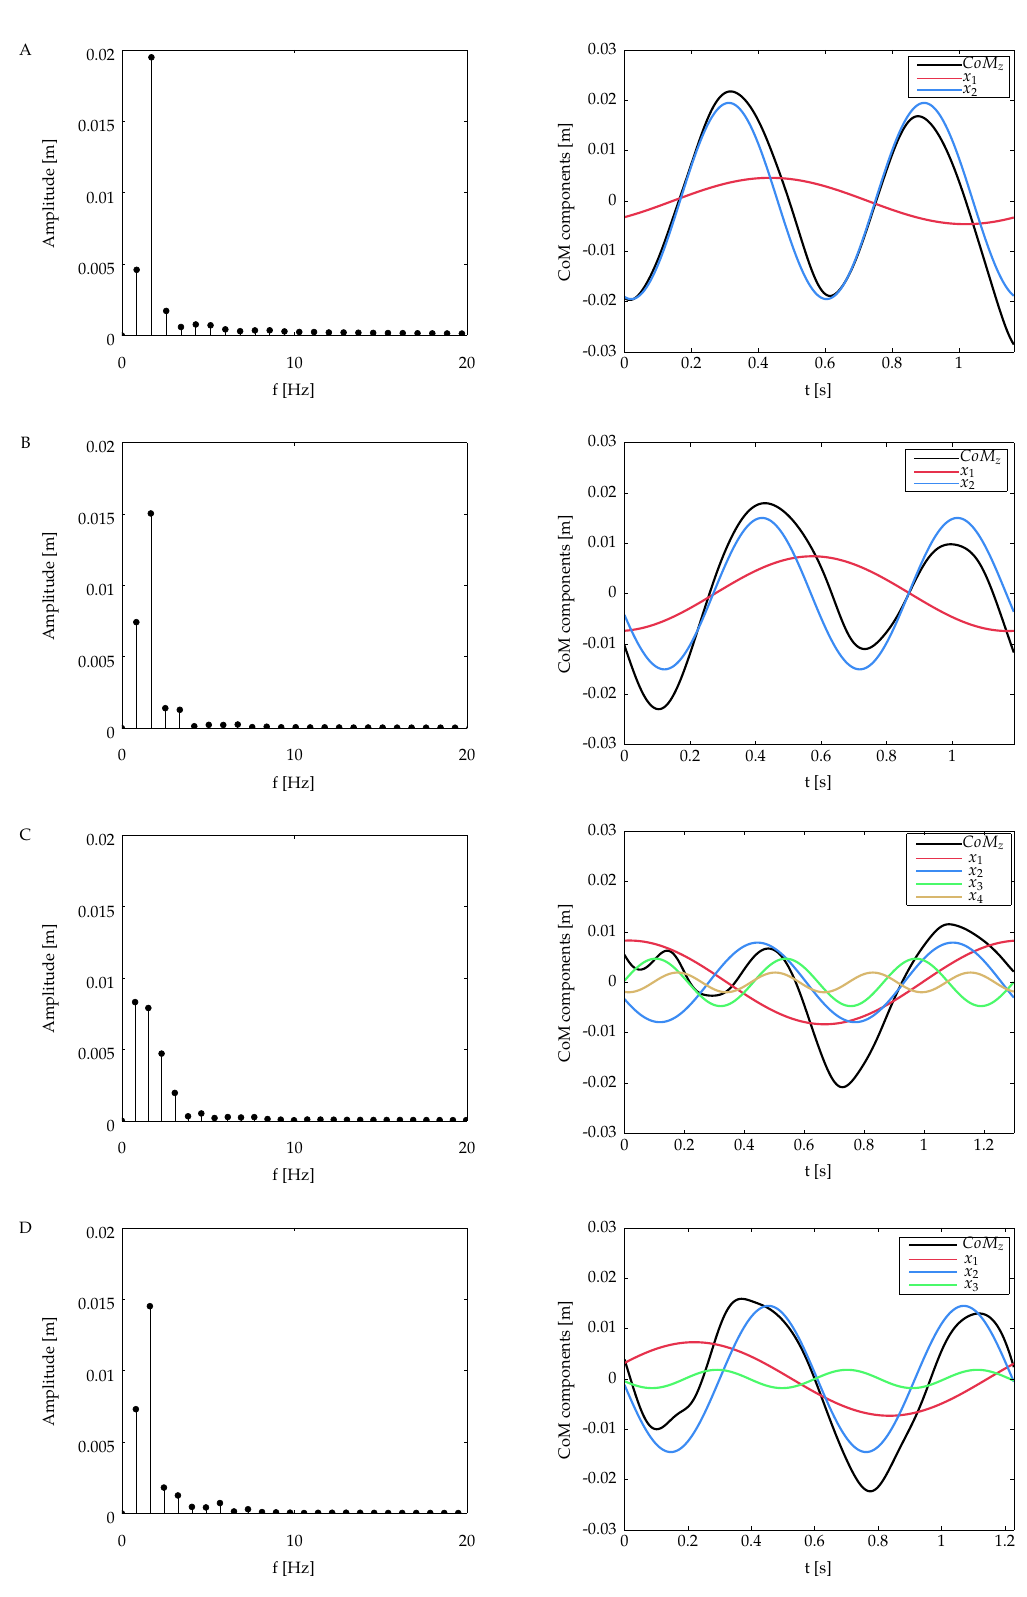
Figure 5. Magnitude spectrum (first column) and decomposition of the vertical CoM signal into its harmonics (second column) for ( A ) the non-amputee and ( B – D ) the amputees’ volunteers. The black curve corresponds to the original waveform.